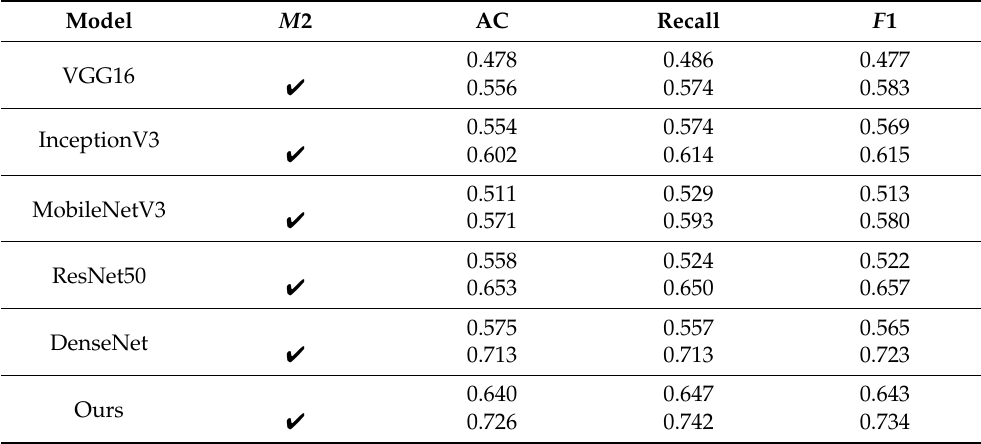
Table 4. Comparison of the method introduced in this paper with other classification models with respect to the M 2 module. We performed two experiments for each model. The first row of experimental results for each model presents the results without the M 2 module. The second row presents the experimental results using the M 2 module.